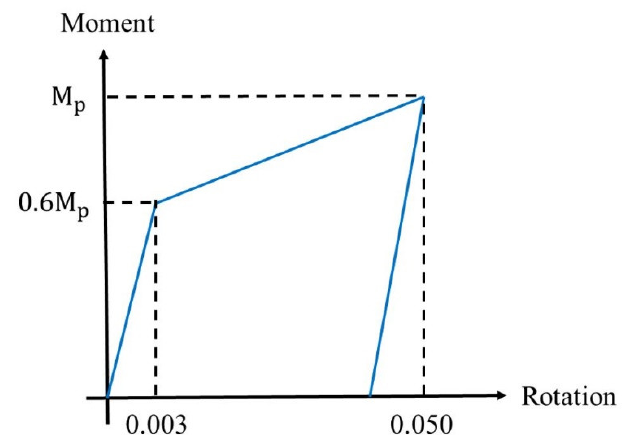
Figure 4. Moment–rotation behavior of the semi-rigid connection.